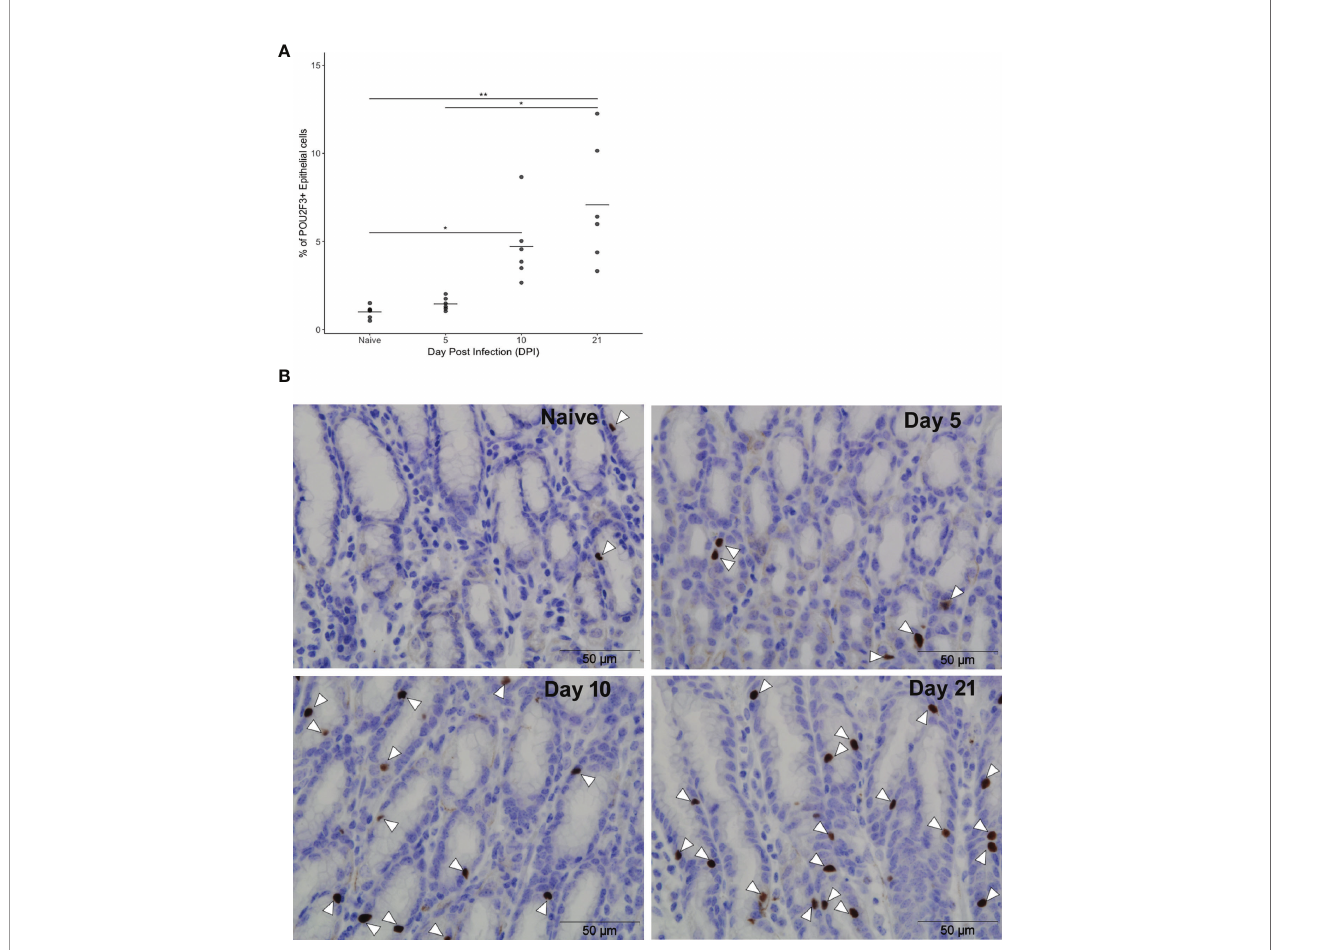
FIGURE 2 | Frequency of ovine abomasal tuft cells increases following GI nematode infection. (A) Percentages of POU2F3 + cells in total epithelium in naïve sheep and at days 5, 10 and 21 following Teladorsagia circumcincta infection. The percentage of POU2F3 + cells from fi ve areas per tissue section was calculated from each of six animals per group as detailed in Supplementary Table 4 . Tuft cells represented 0.9% ± 0.3 (mean ± standard deviation), 1.5% ± 0.4, 4.7% ± 2.1 and 7.1% ± 3.4 of epithelial cells in the abomasum of naïve animals and at days 5, 10 and 21 p.i., respectively. * indicates P ≤ 0.05; ** indicates P ≤ 0.01. P values were calculated using a Dunn ’ s Multiple comparison test. Horizontal lines indicate mean values. (B) Representative images of POU2F3 + cells (brown) in the ovine abomasum epithelium from naïve sheep and at days 5, 10 and 21 after T. circumcincta infection. White arrowheads indicate POU2F3 +